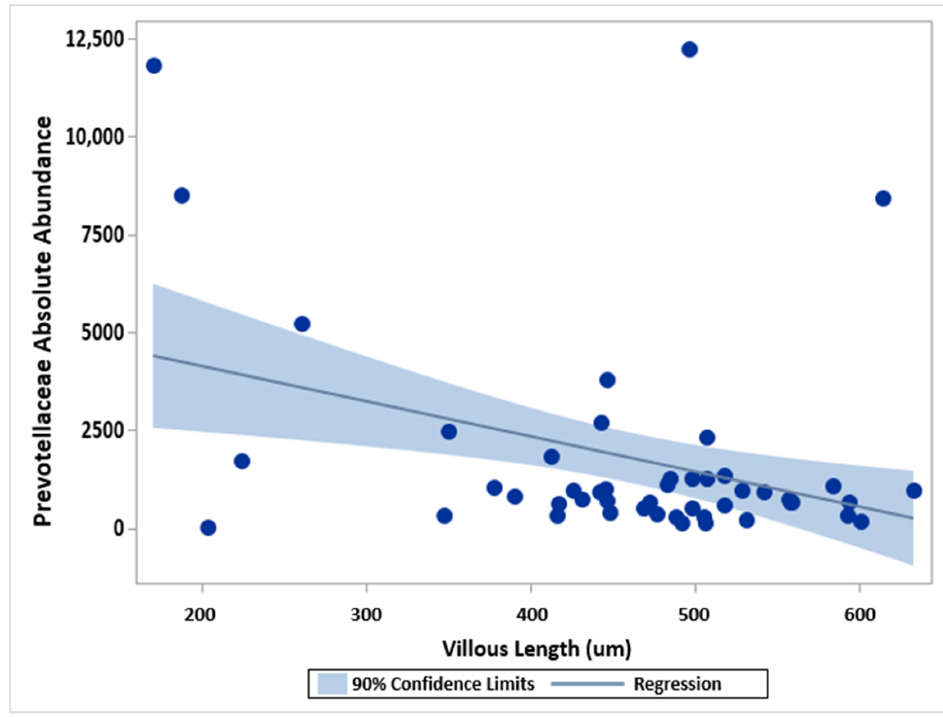
Figure 5. Scatter plot of absolute abundance of Prevotellaceae in all duodenal samples, with duodenal villous lengths fit with a linear regression and 90% confidence interval (shaded area). Table 6. Pearson correlation analysis of TI villous length (when available) and bacterial OTU abun- dance. Correlation coefficient reported between each OTU and villous length, with p value reported in